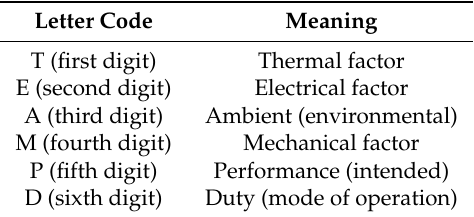
Table 1. Insulation system codes—General description